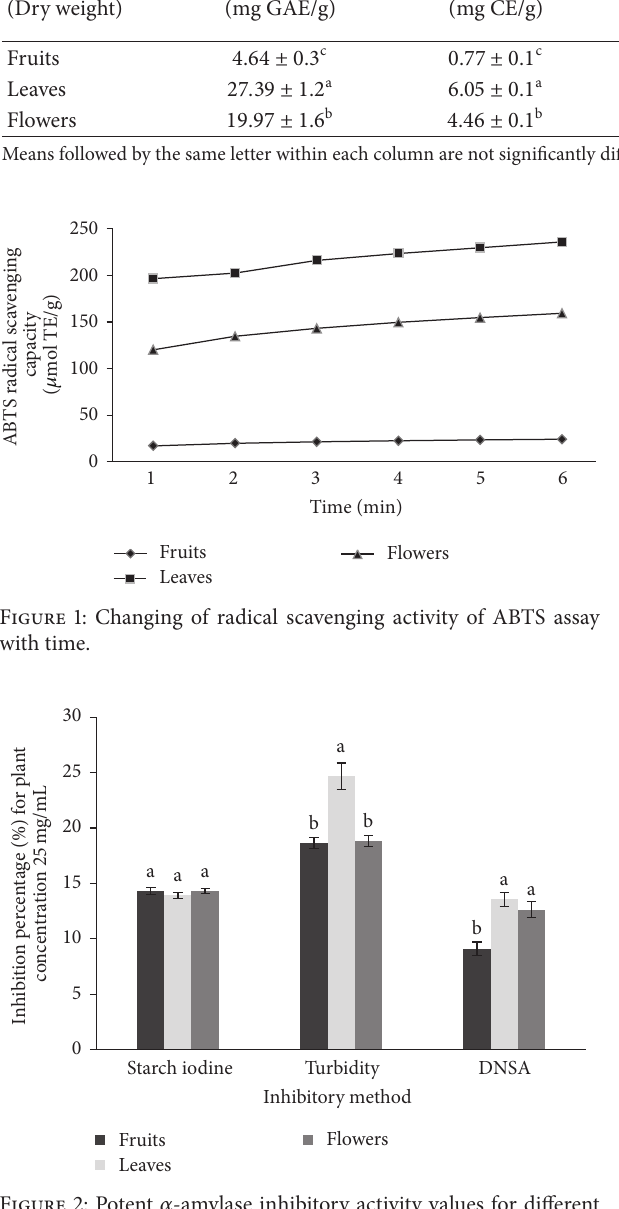
Figure 2: Potent 𝛼 -amylase inhibitory activity values for different assays.Meansfollowedbythesameletter(s)(aandb)withinacluster are not significantly different at 𝑃 > 0.05 .